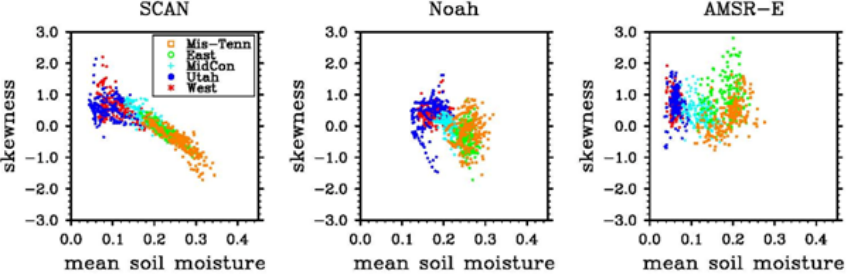
Fig. 5. Soil moisture skewness as a function of spatial mean soil moisture (cm 3 cm − 3 ) for the three data types. Statistics of Noah and AMSR-E were calculated using data at SCAN locations.